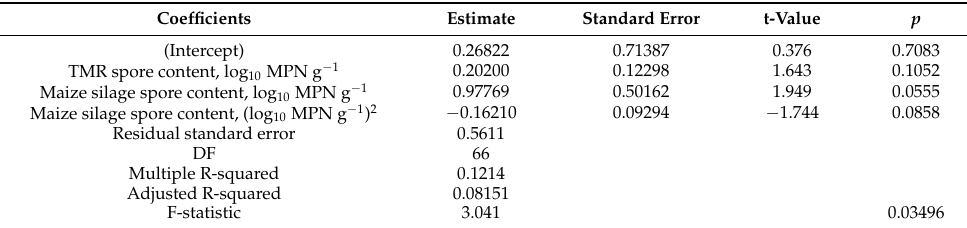
Table 4. Linear regression analysis of the log 10 most probable number of spores (MPNld) from each bulk milk sample, and of the spore content of maize silage and TMR fed to lactating dairy cows from the same herd.